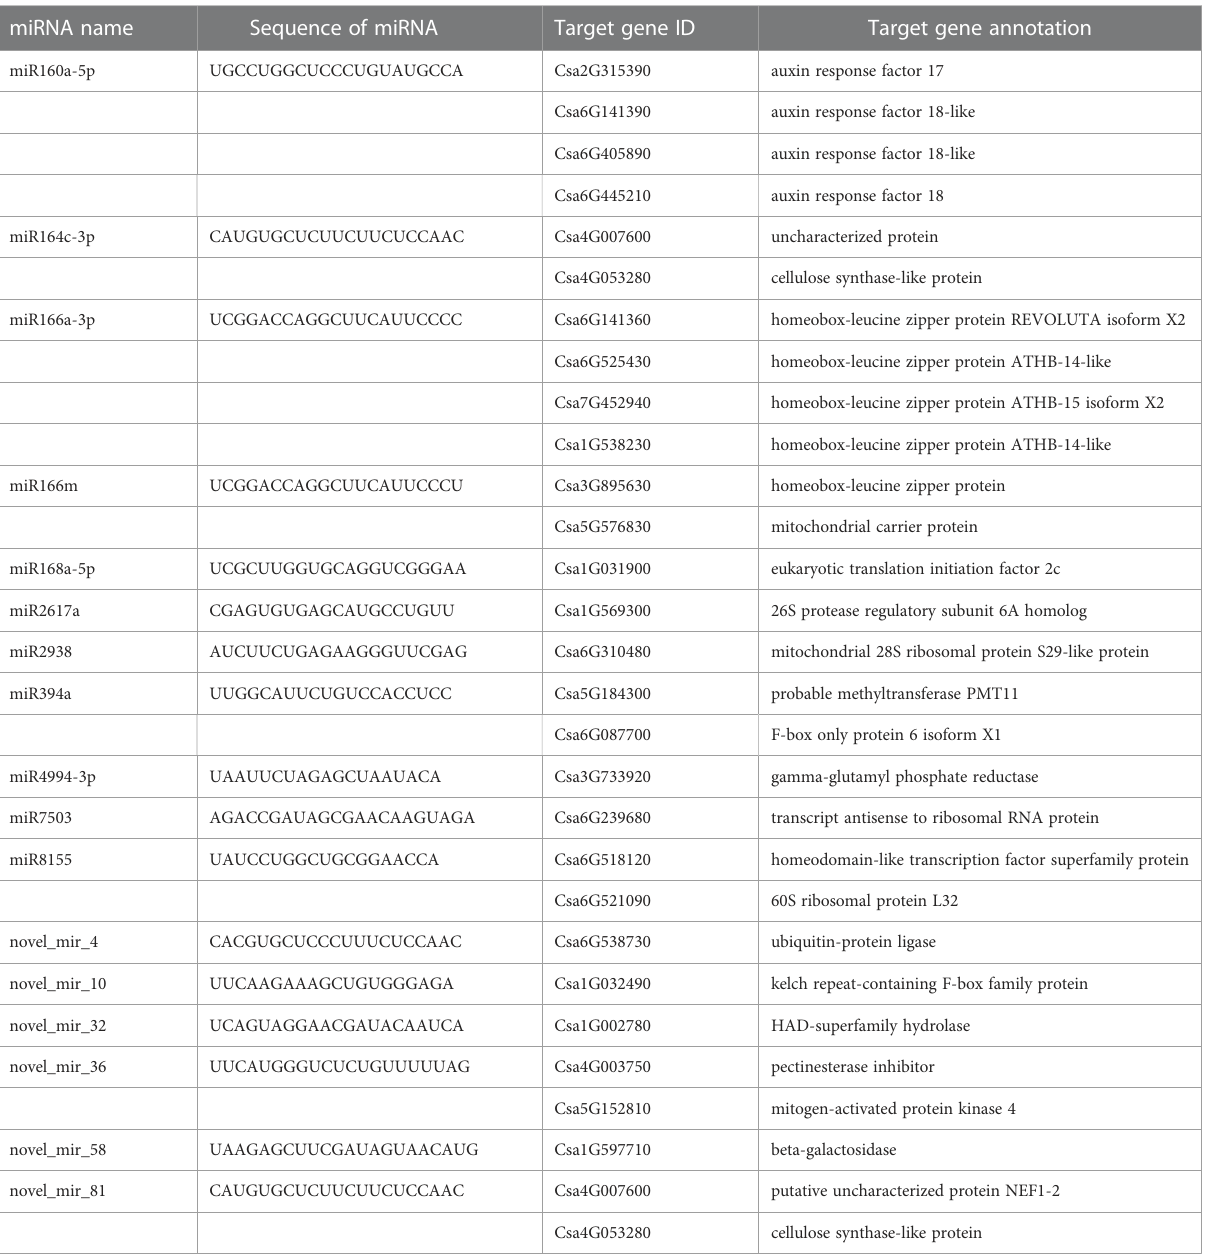
TABLE 3 Candidate miRNA and their targets of know and novel miRNAs. miRNA name Sequence of